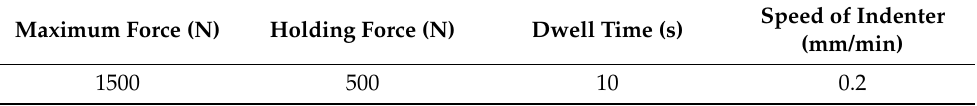
Table 2. Parameters of the indentation test ( F max = 1500 N ).